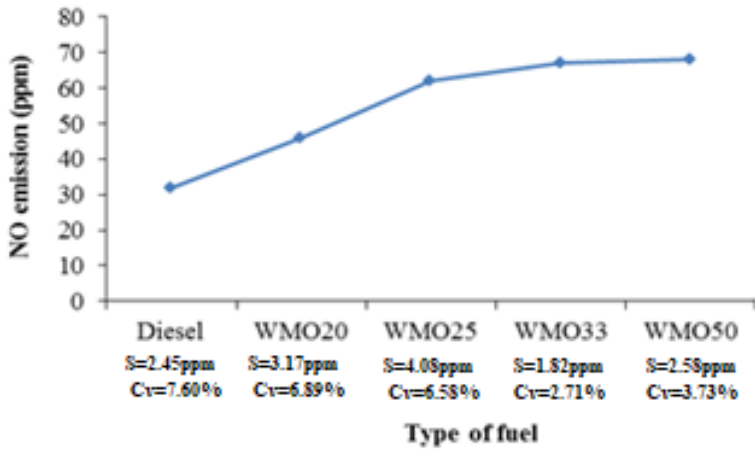
coefficient (Cv) of measurement results for gaseous components NO, CO and CO 2 caused the experiment was repeated four times for each fuel used. The results were compared, by combustion of fuel D4 and its mixtures with WMO are shown in Figures 2–4. and no major discrepancies were observed. Values of standard deviation (S) and variation